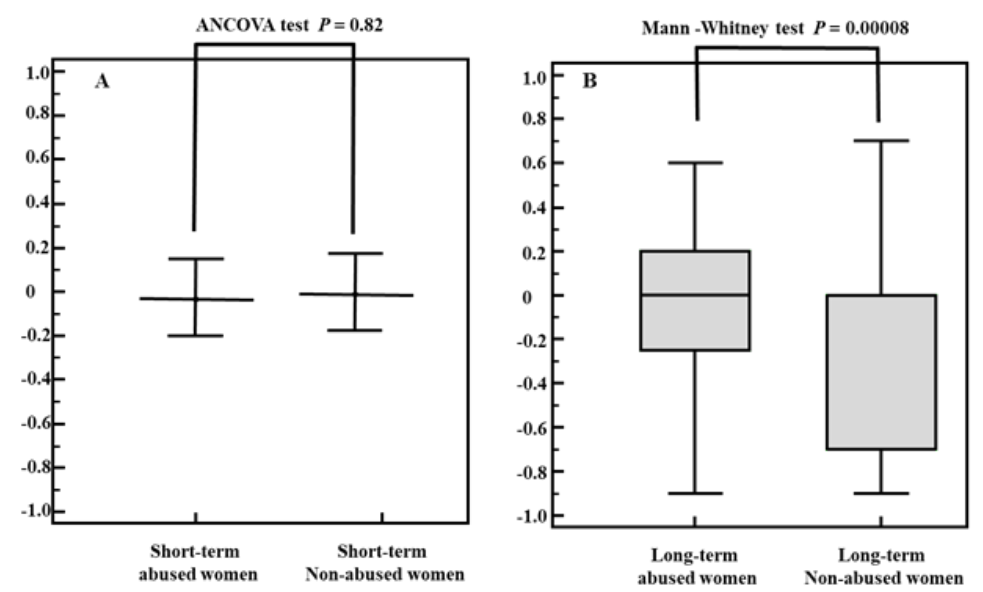
Figure 1. Graphical representation of choices for ( A ) short-term relationship (Mean and CI 95%) and ( B ) long-term relationship (Median and CI 95%) between the two study groups. Table 2. The Analysis of Covariance (ANCOVA) of short-term relationship with adjusted means weighted for the covariates and Cohen’s d effect size.